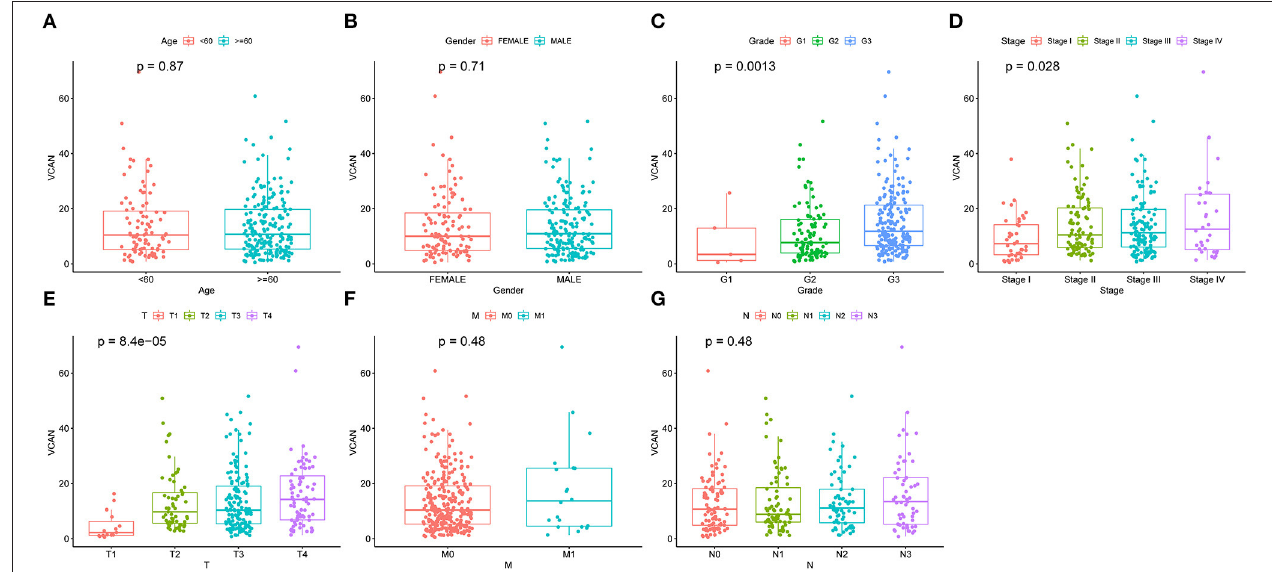
FIGURE 5 | An Upregulated VCAN is associated with the GC progression. The clinical characteristics, including (A) age. (B) Gender. (C) Grade. (D) Stage. (E) T stage. (F) M stage, and (G) N stage of VCAN. Of which, upregulated VCAN indicates higher pathological grade ( p = 0.0013), stage ( p = 0.028), and T stage ( p = 8.4e-5). The relationship between the VCAN and clinical characteristics was analyzed by Wilcox’s of R software.